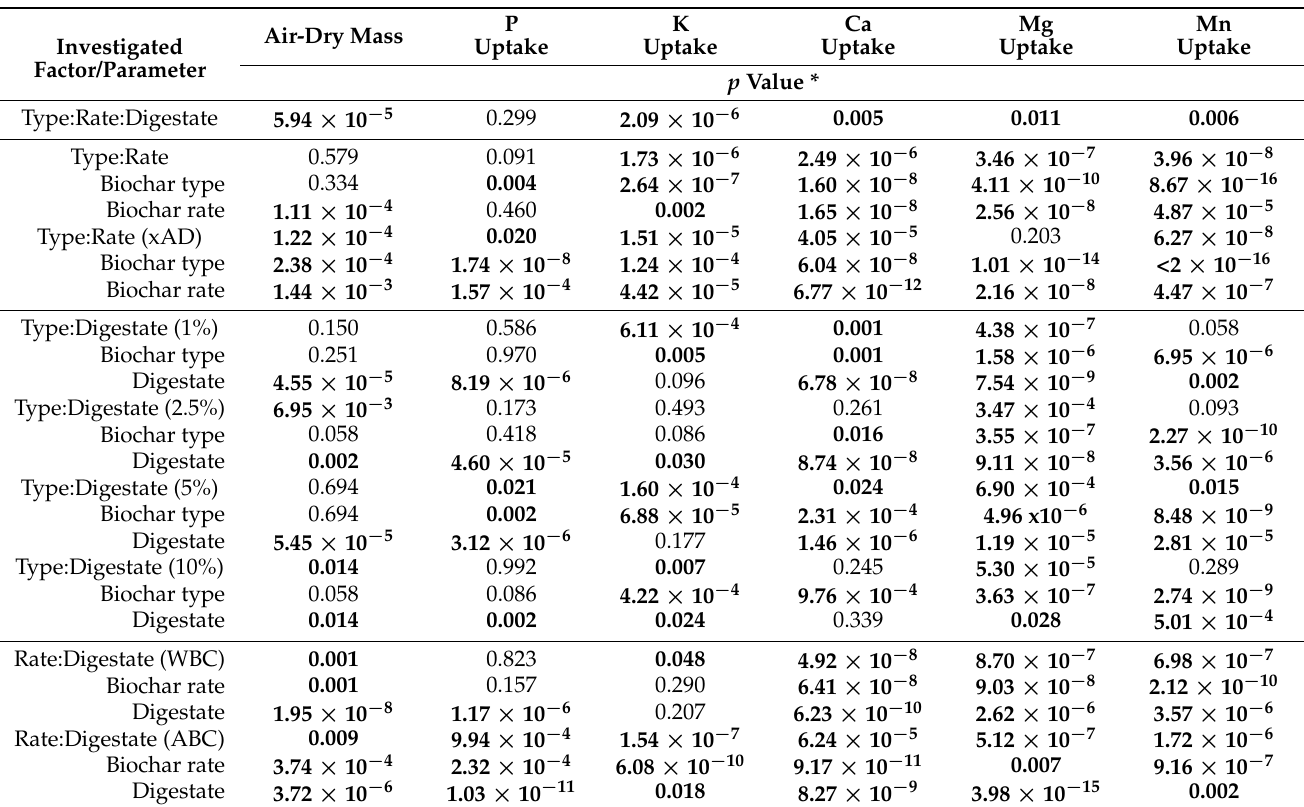
Table 4. Effects and interactions of the investigated factors on the yield (air-dry mass) of ryegrass ( Lolium perenne ) and uptake of certain elements at the end of the growing period based on plant tissue